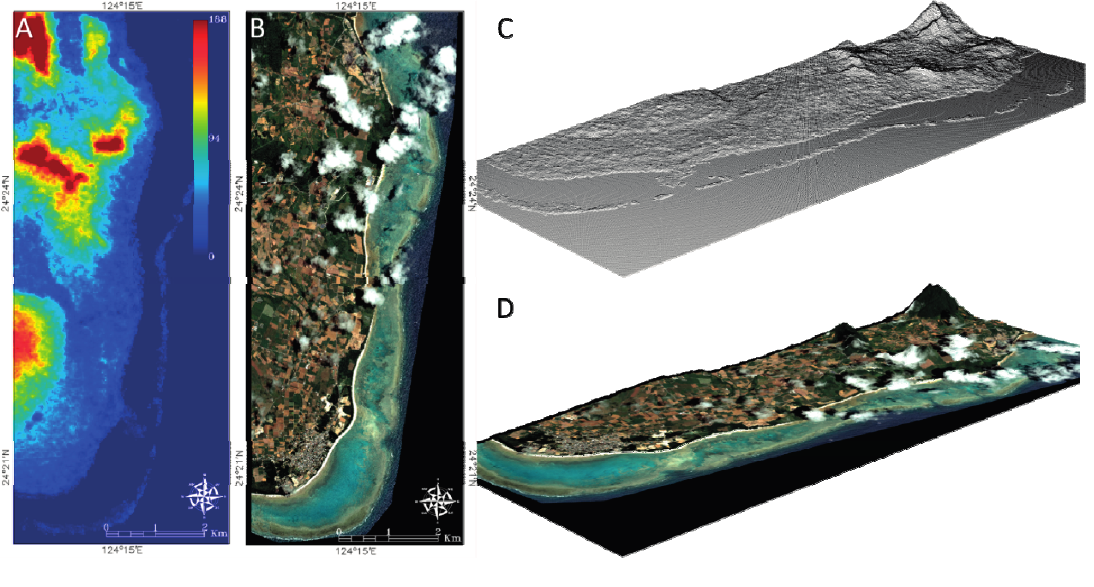
Figure 5. Maps of the ( A ) elevation and ( B ) natural-colored (RGB) data over the study site stemming from Global Digital Elevation Model Version 2 and Google Earth-derived very high resolution mosaic, respectively. Based on xyz data, ( C ) a 3D point cloud was built, over which the RGB image was draped ( D